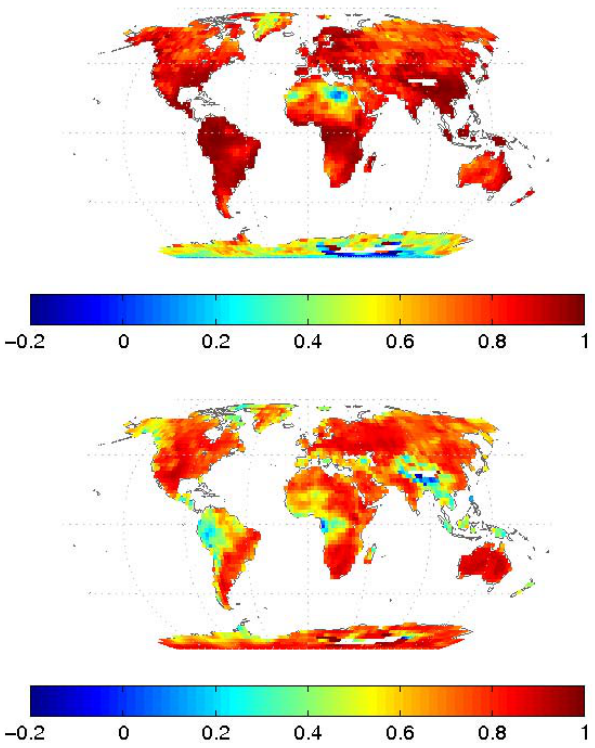
Fig. 9. Geographically distributed correlation coefficient between trends of E p and E r (top) and between trends of E p and E a (bot-